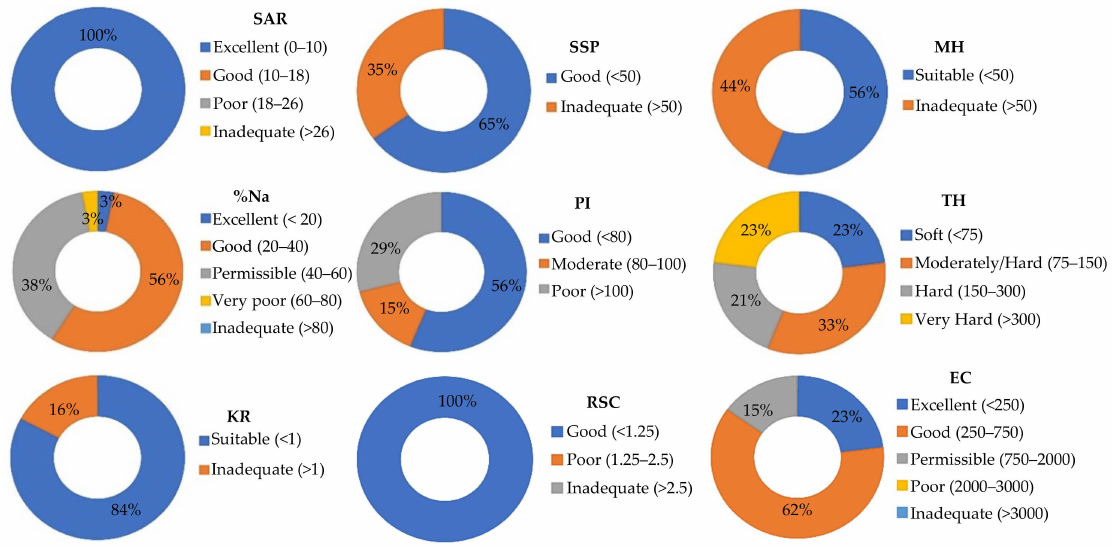
Figure 13. Classification of water samples for irrigation purposes in the Cuernavaca